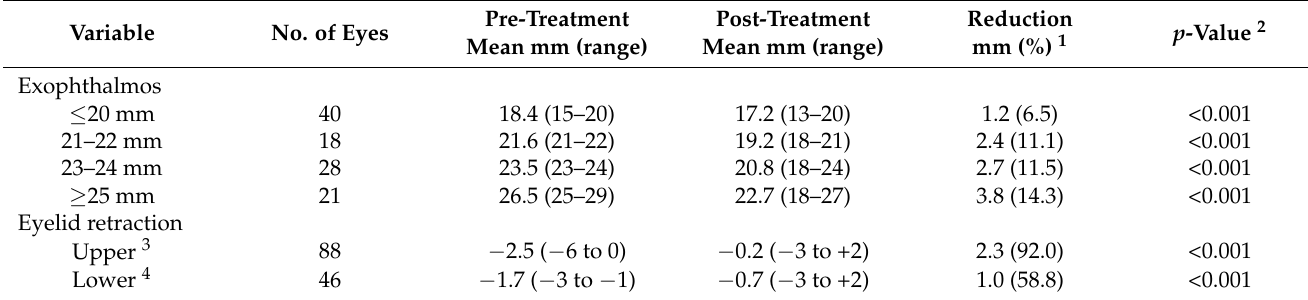
Table 3. Exophthalmos and eyelid retraction before and after treatment with tocilizumab.